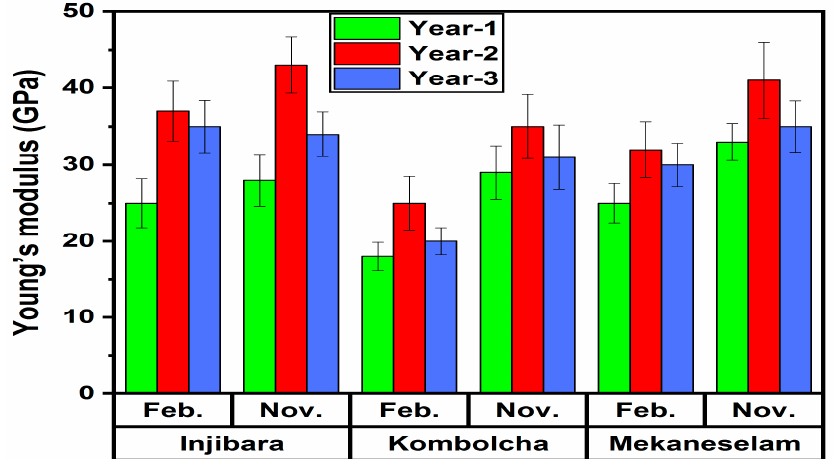
Figure 10. Back-calculated Young’s modulus of bamboo fibre in Ethiopia from